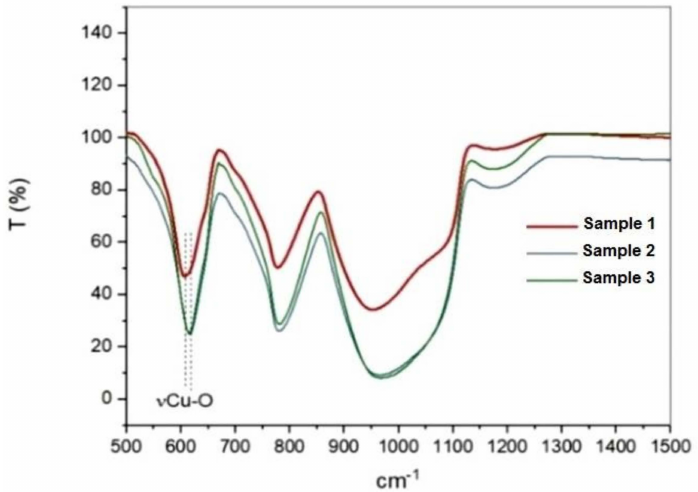
Figure 7. FTIR transmission spectra for Cu 2 O:N thin film: Sample 1, Sample 2, and Sample 3